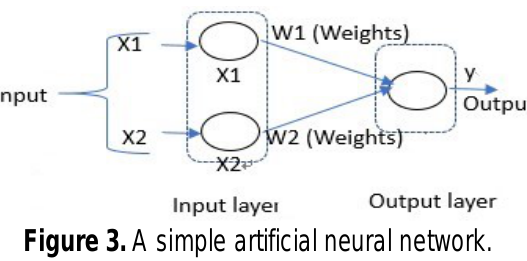
Figure 3. A simple artificial neural